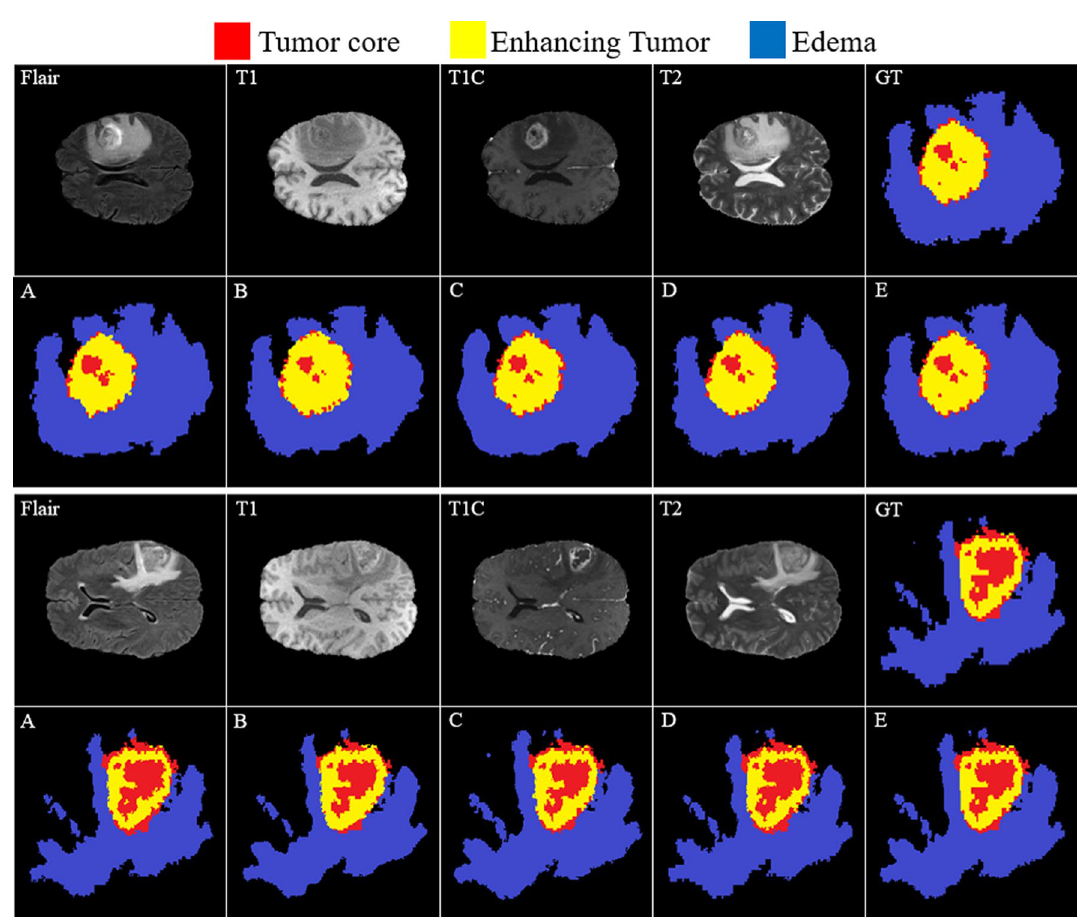
Figure 15. Comparing the results of brain tumor segmentation using the proposed strategy with four state-of-art methods (the blue, yellow, and red colors are edema, enhanced, and core regions respectively). ( A ) Multi-Cascaded 34 , ( B ) Cascaded random forests 10 , ( C ) Cross-modality 22 , ( D ) One-Pass Multi-Task 23 , and ( E ) Our